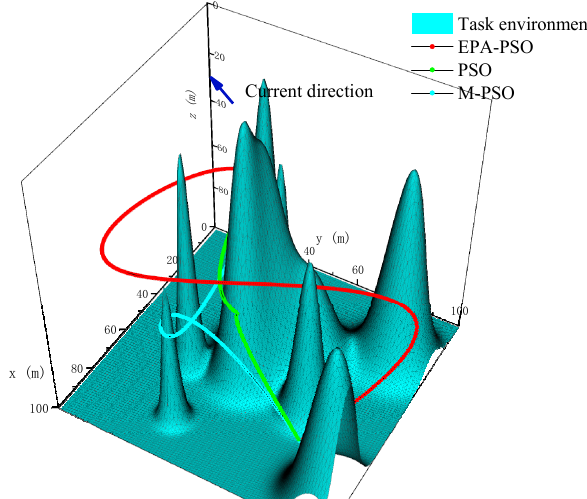
Figure 21. Numerical comparison of cost functions of trim angle after 500 iterations.